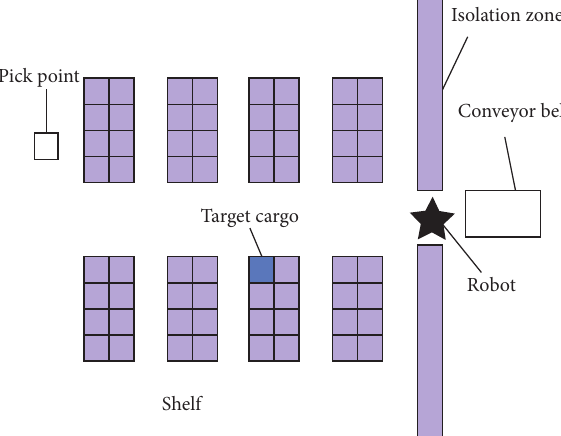
Figure 3: Partial schematic diagram of simulated storage